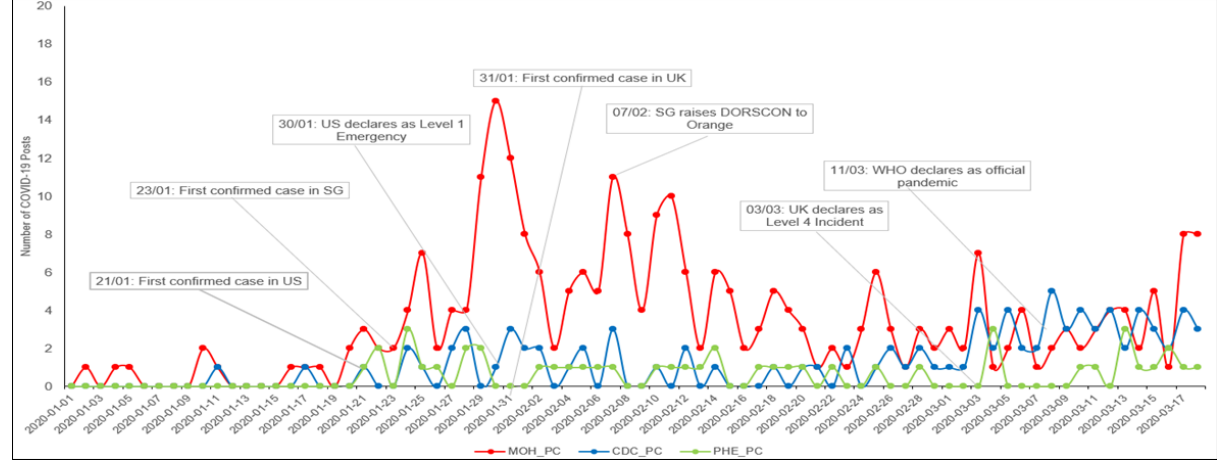
Figure 1. COVID-19 posts frequency during the analysis period. CDC_PC: Centers for Disease Control and Prevention's number of posts; COVID-19: coronavirus disease; DORSCON: Disease Outbreak Response System Condition; MOH_PC: Ministry of Health's number of posts; PHE_PC: Public Health England number of posts; SG: Singapore; WHO: World Health